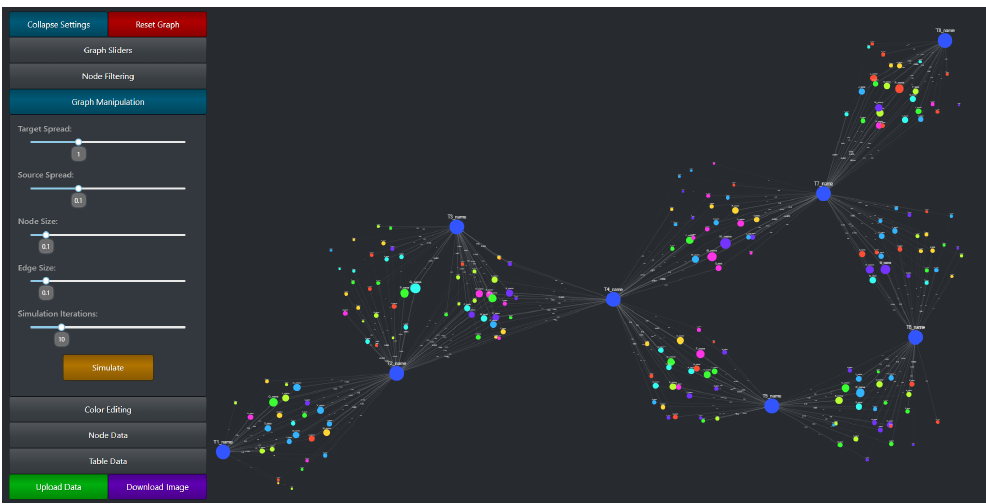
Figure 7. The complete CompositeView application layout (with Graph Manipulation settings open).